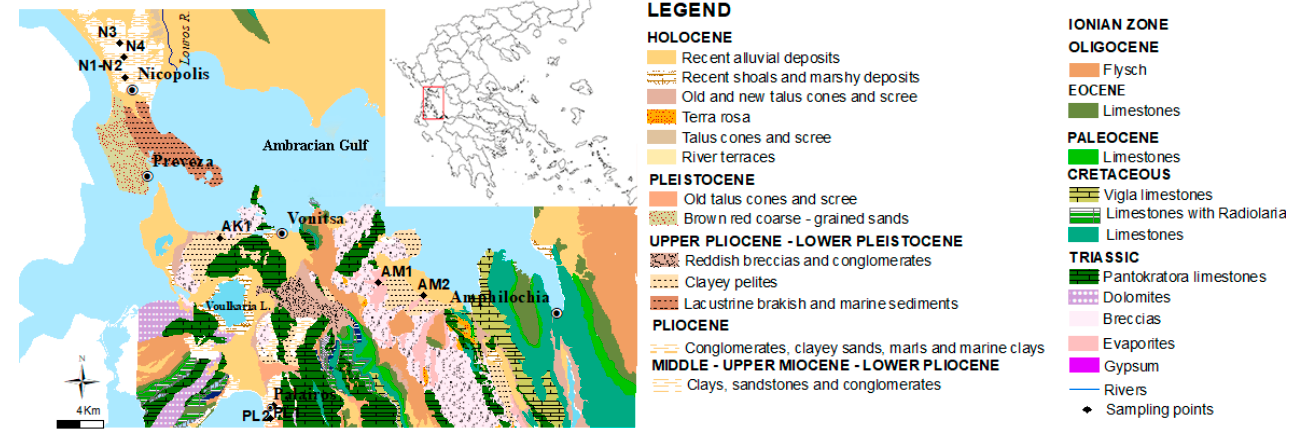
Figure 2. Modified geological map of south Epirus, combined from IGME sheets of Peta, Vonitsa,